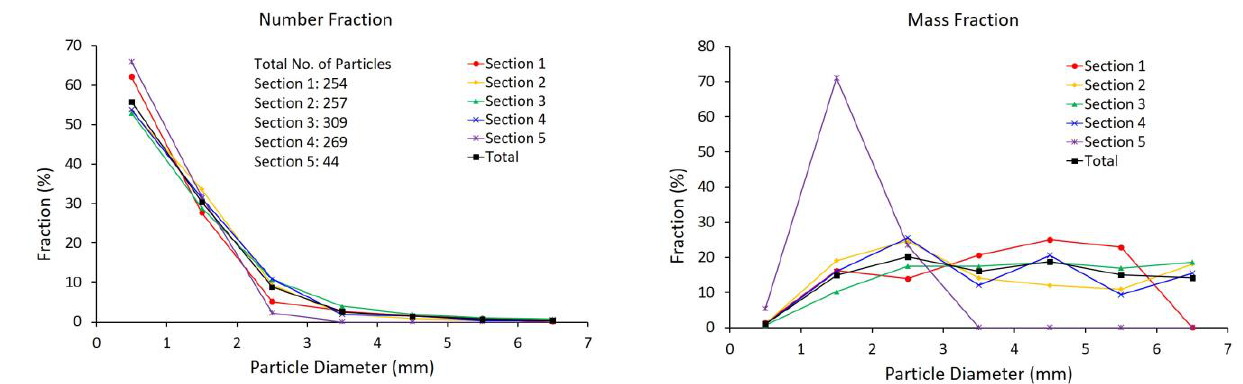
Energies 2022 , 15 , x FOR PEER REVIEW Figure 5. Five sections and image analysis for particle size distributions. Figure 5. Five sections and image analysis for particle size distributions.